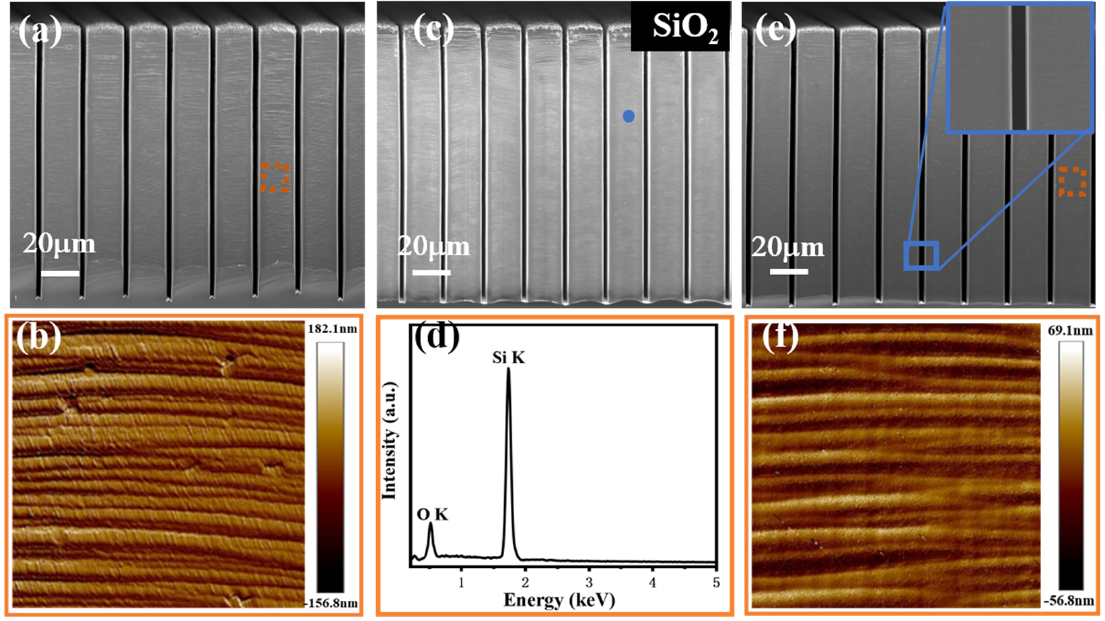
Figure 7. ( a ) The SEM image of micropillars before thermal oxidation. ( b ) AFM images of the orange box in panel ( a ). ( c ) The SEM image of micropillars after thermal oxidation. ( d ) EDS elemental mapping measurement of blue dots in ( c ). ( e ) The SEM image of smooth micropillars after removal of the oxide layer. ( f ) AFM images of the orange box in ( e ).